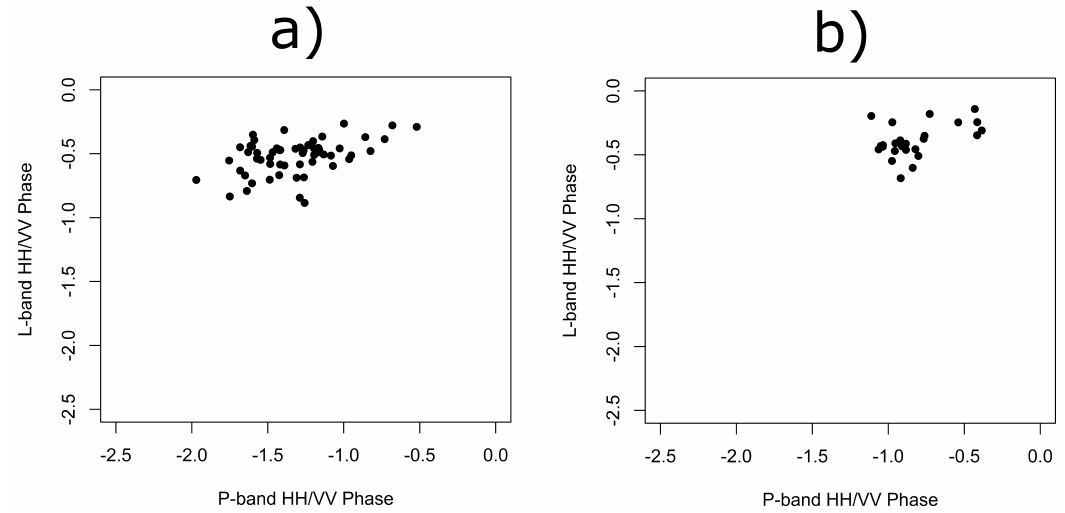
Figure 3. Comparison of co-polarized phase difference of P- and L-band in the forest stands in Remningstorp (( a ) 2 May 2007) and Krycklan (( b ) 313 ◦